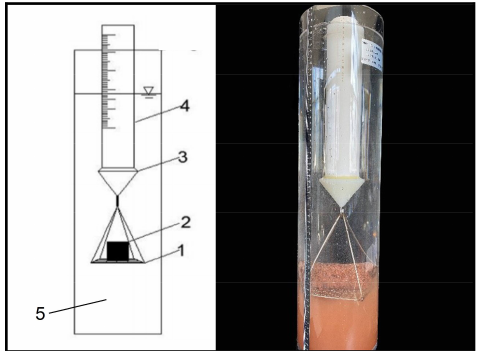
Figure 6. Disintegration test